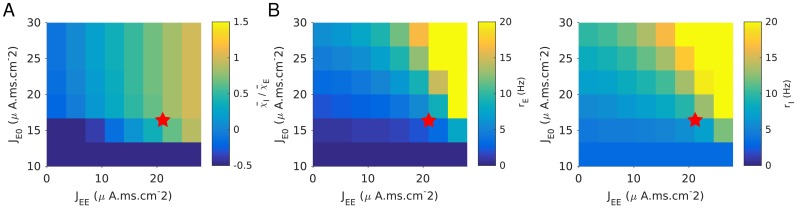
Two-population model.The response of the PC and PV populations upon stimulation of the latter are proportional only if parameters are fine-tuned. (A) χ-I/χ-E where χ¯α=rαlight on/rα-1/Γopto estimated for Γopto=0.5mW.mm-2. The ratio is close to one only if JEE≈JEIJIE/JII=30μA.ms.cm-2. (B) Red star indicates the approximate center of the region with proportionality of the responses together with reasonable activities. Parameters as in Figure 3. K = 500.